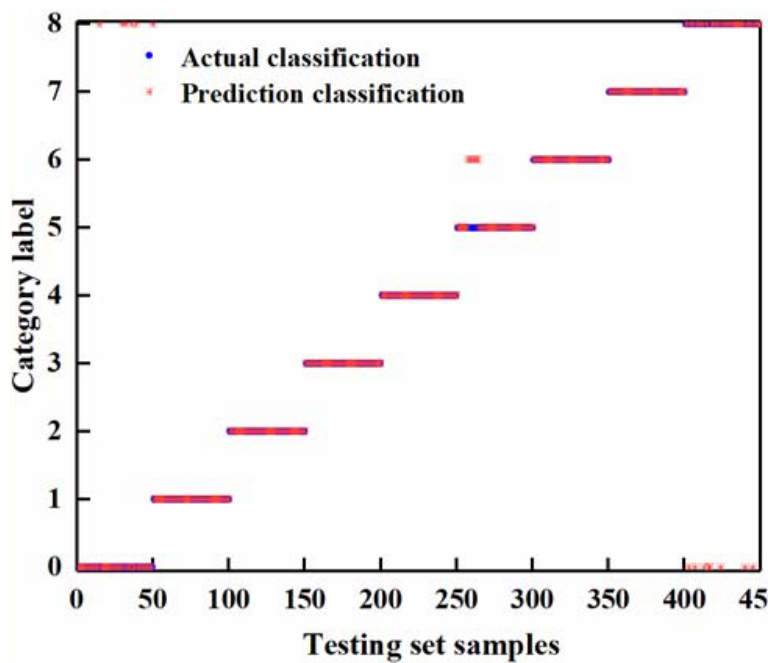
Figure 9. Predictive classification results of the GA ‐ SVM algorithm.